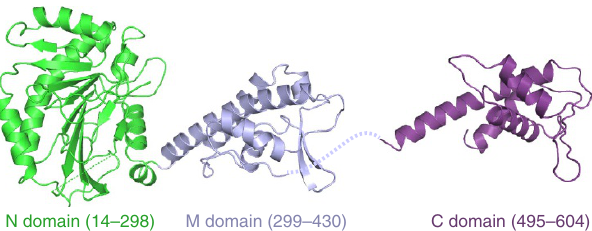
Figure 2 | Crystal structures of the N-terminal and middle domains (left) and the C-terminal domain (right) portions of S. cerevisiae Cdt1. The protein chains are shown as cartoons, with the N domain, M domain and C domain in green, blue and violet,